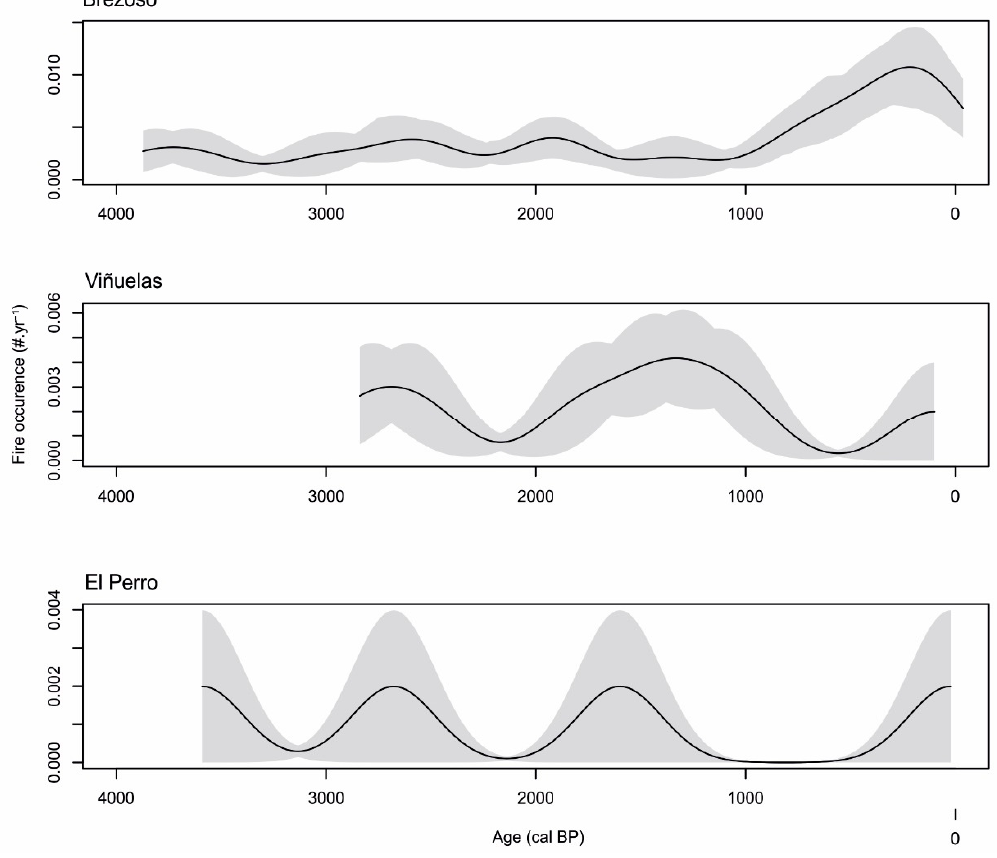
Figure A1. Fire Frequency in the selected mires.